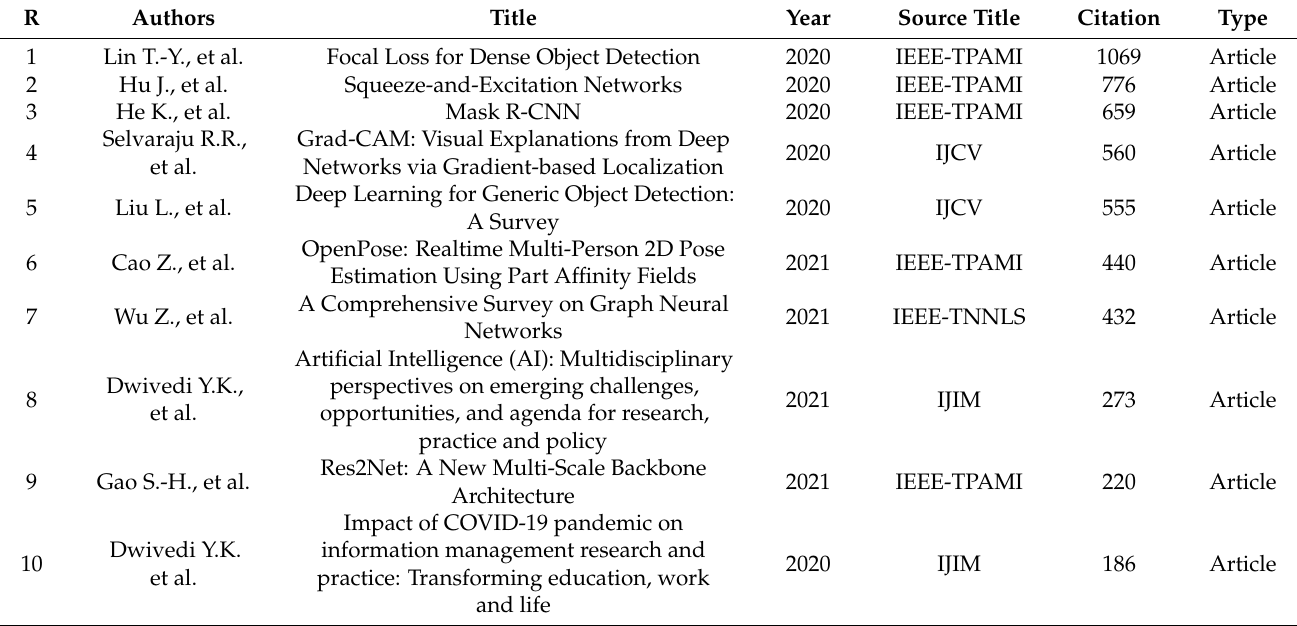
Table 6. Most cited documents in the leading AI journals during (2020 and 2021).